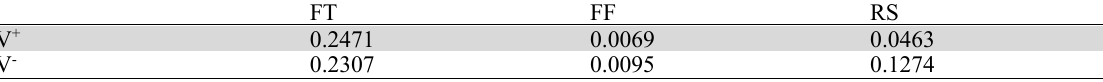
The ideal and negative ideal solutions